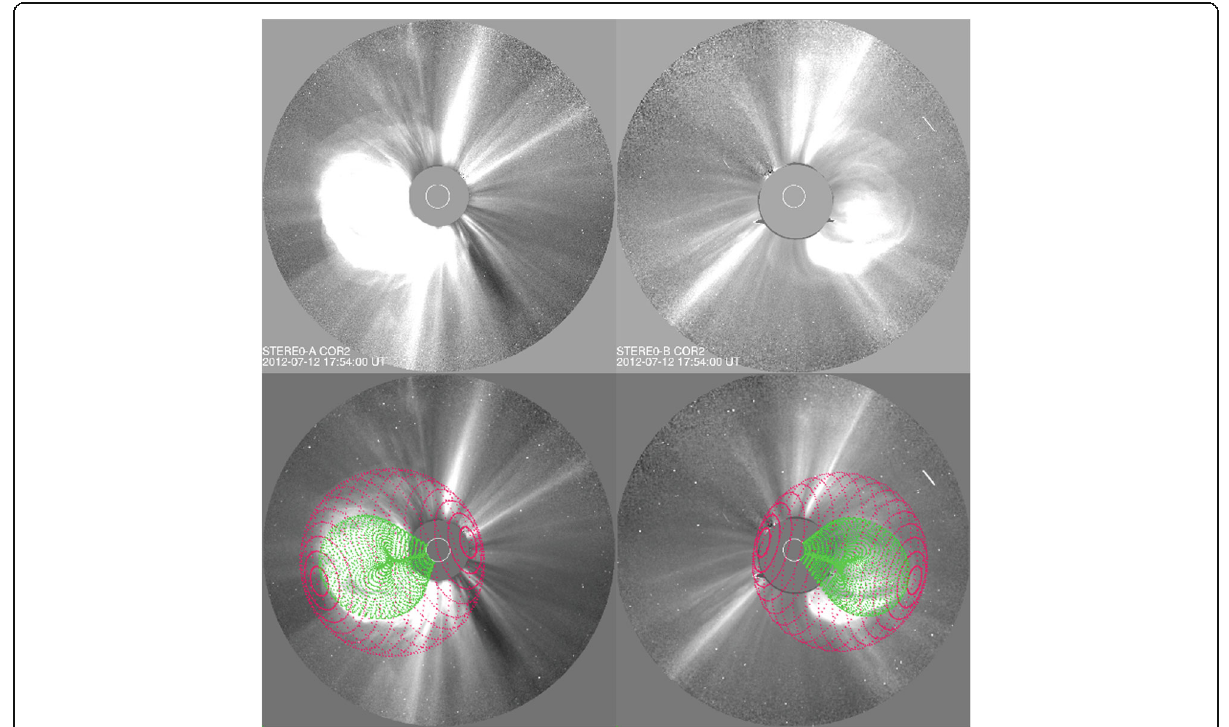
Fig. 2 Forward model fitting of CME ejecta front and CME-driven shock front of July 12, 2012 event based on STEREO-A COR2 (left) and STEREO- B COR (right) images, along with (bottom) and without the raytrace mesh. The green mesh shows the GCS fitting to the eject front, whereas the red mesh shows the spheroid fitting to the shock front (adapted from Hess and Zhang